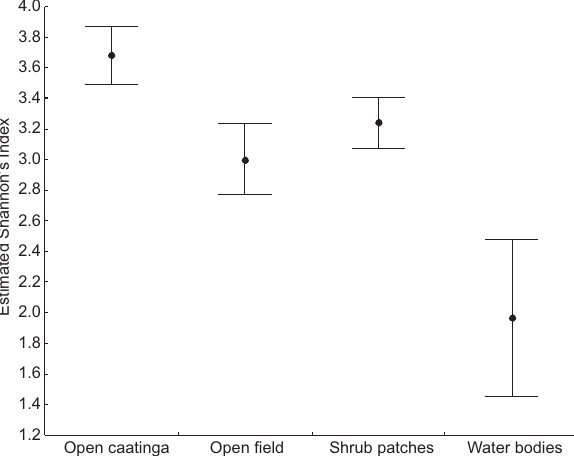
Figure 6. Estimate of Shannon’s diversity index of bird species re- corded in each environment. The bars indicate the confidence intervals of 95%.